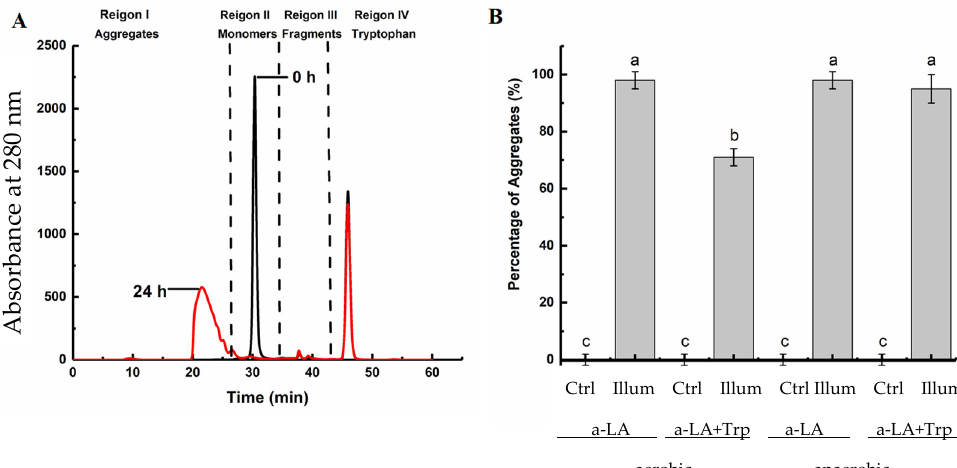
Figure 2. ( A ) Chromatogram of apo- α -LA in the presence of 2.8 mM Trp under anaerobic conditions after 0 h (black) and 24 h illumination (red). ( B ) Yield of total aggregates formed in illuminated apo- α -LA in the absence or presence of 2.8 mM Trp under aerobic and anaerobic conditions. Results are presented as mean values obtained from three independent experiments with standard deviations shown by error bars. Means with different letters are significantly different.